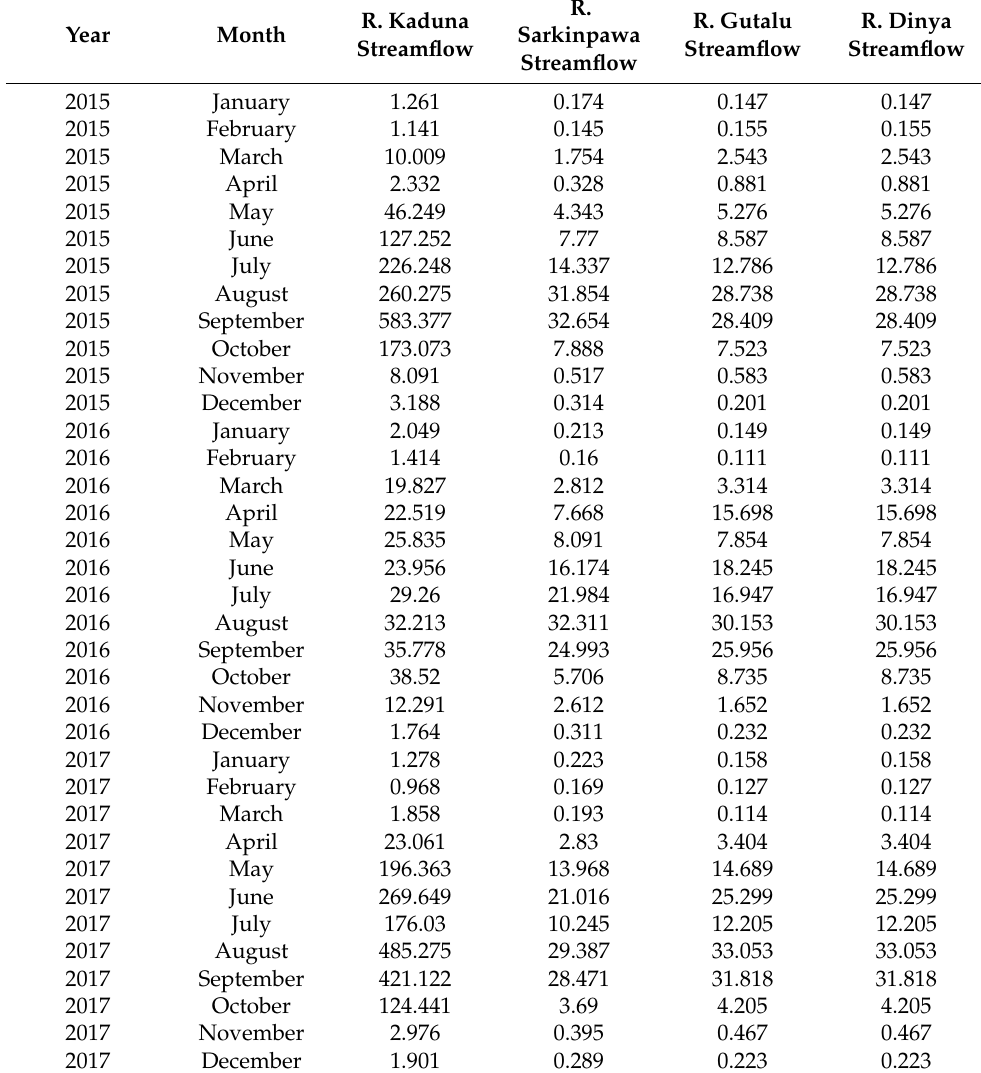
Table A2. Streamflow data of Rivers Kaduna, Sarkinpawa, Gutalu and Dinya in the years 2015–2017.